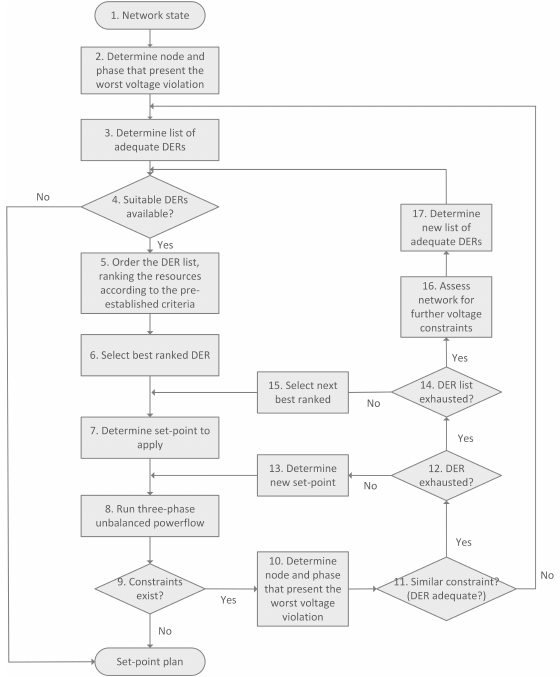
Figure 3. Flowchart of Control Actions Management Module